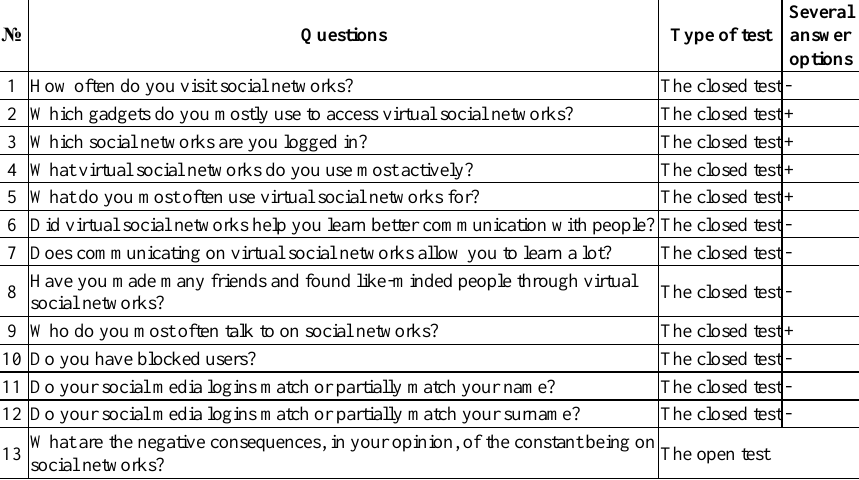
Table 1. A series of questions for the